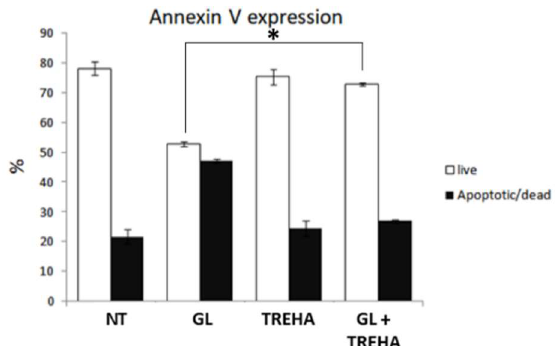
Figure 12. Viability and apoptotic analysis of Caco-2 cells after treatment with digested gliadin (1 µ g / µ L), trehalose (100 mM), and the combination of both. The Annexin V protocol was performed using a Muse ® Cell Analyzer (Merck) at 24 h p.t. SE bars are reported. The asterisk indicates p < 0.05, ANOVA one-way, as compared with NT sample. The experiments were performed in triplicate. Cytofluorimetric plots are reported in